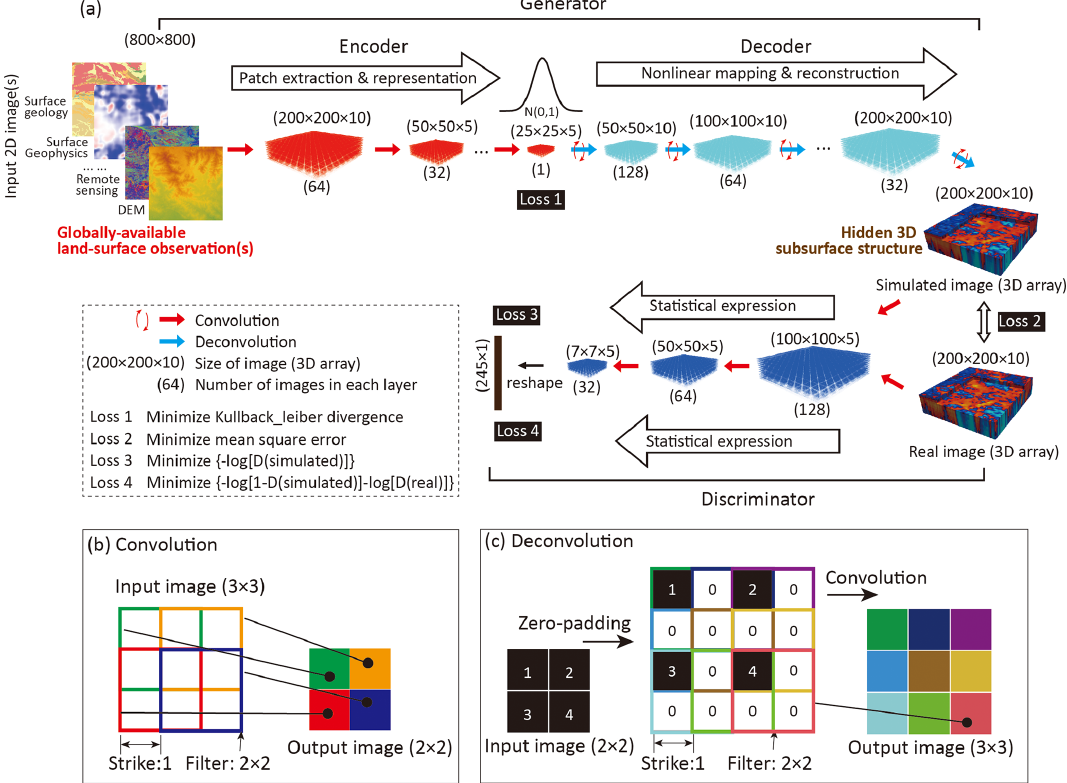
Figure 2. (a) Adversarial convolution neural network composed of (1) encoder for input image(s) (e.g., surface geology map, uninterpreted geophysics prospecting, remote sensing images, and digital elevation model) patch extraction and representation, (2) decoder for nonlinear mapping and 3D image (i.e., hidden subsurface structure) reconstruction, (3) discriminator for distinguishing the output 3D image and real image after statistical expression, and features of the (b) convolution and (c) deconvolution processes with the color representing the origin of the deconvoluted values. For mapping paleovalley patterns in an Australian desert landscape, as an example in this study, the input data use the 2D MrVBF (an index calculated from globally available digital elevation model) with random white noise; the output is a 3D probability map of paleovalley presence. For convenience of 3D convolution, the 2D input image (800 × 800 × 1) is simply repeated in 10 layers to form a 3D input dataset (800 × 800 × 10); following a structure optimization by trial and error, the encoder is designed to contain four layers, with a width of 64, 32, 32, and 1 in each layer. The decoder contains six layers, with a width of 1, 16, 32, 32, 64, and 128, and the discriminator contains four layers with a width of 128, 64, 32, and